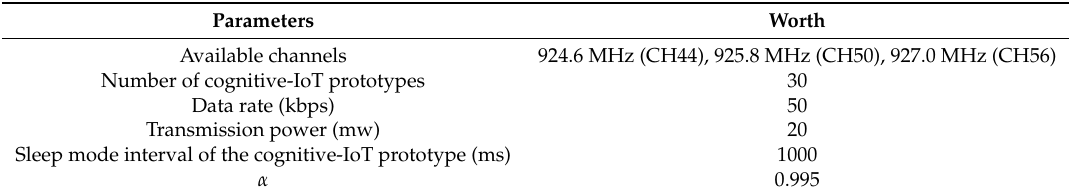
Table 2. Experiment